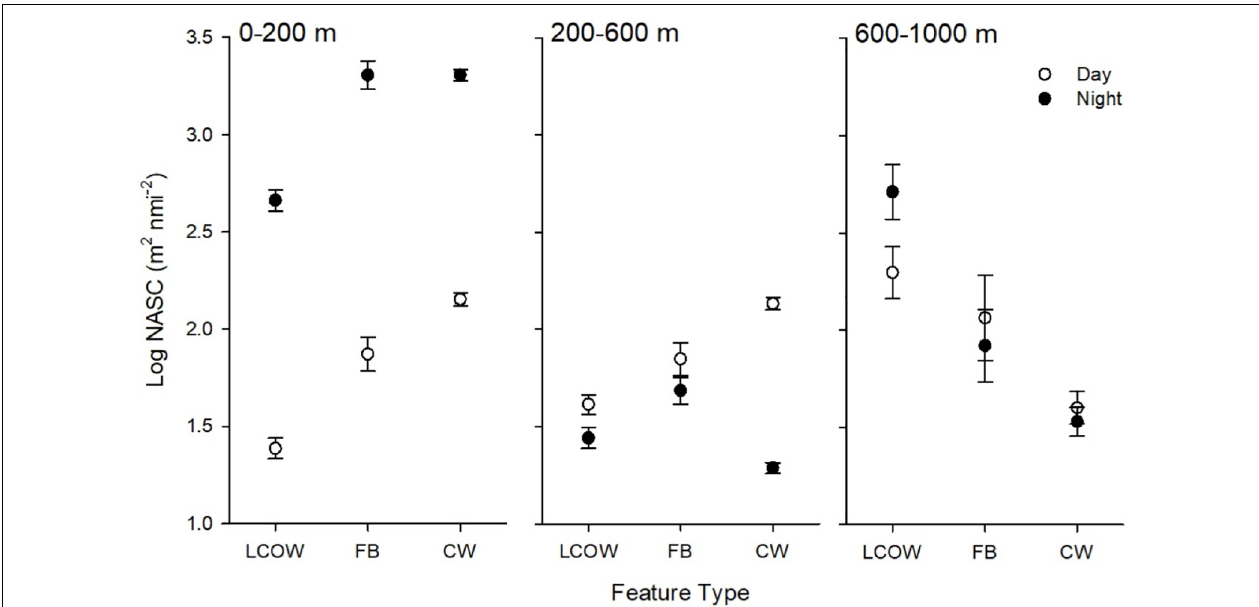
FIGURE 3 | Least-squared means of acoustic backscatter, log 10 NASC (m 2 nmi − 2 ), by feature class, time of day (open symbols are day, filled are night) and depth interval. LCOW, Loop Current-origin water; FB, frontal boundary; and CW, Gulf Common Water. Error bars represent standard error from least-squared mean estimates.